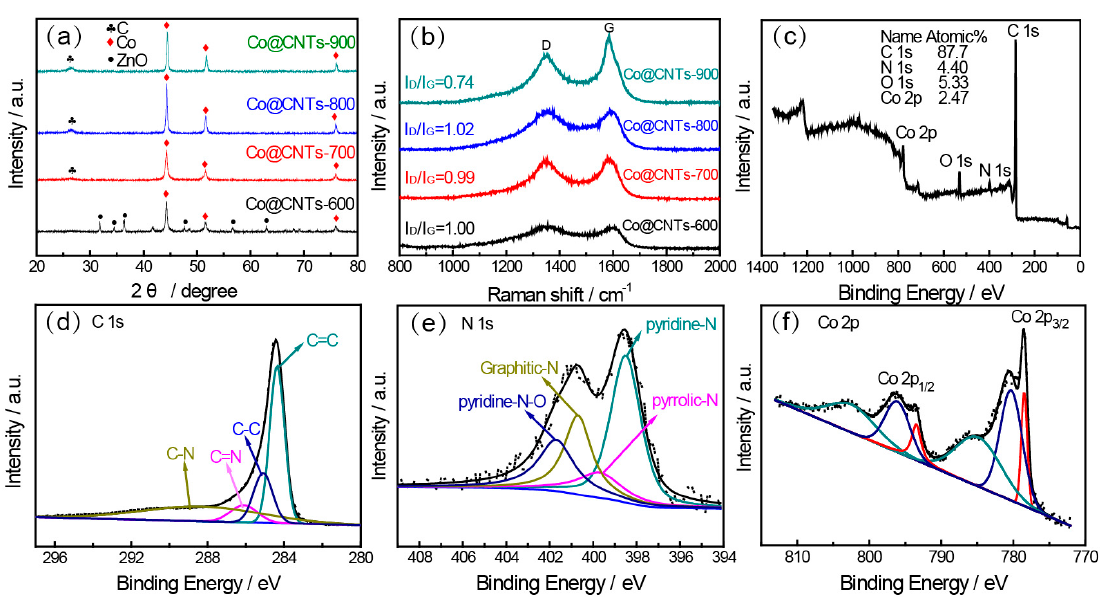
Figure 3. ( a ) XRD patterns of Co@CNTs-T (T = 600, 700, 800, and 900, respectively); ( b ) Raman spectra of Co@CNTs-T (T = 600, 700, 800, and 900, respectively); ( c ) XPS survey spectra of Co@CNTs-800; ( d ) C 1s XPS spectra of Co@CNTs-800; ( e ) N 1s XPS spectra of Co@CNTs-800; ( f ) Co 2p XPS spectra of Co@CNTs-800.